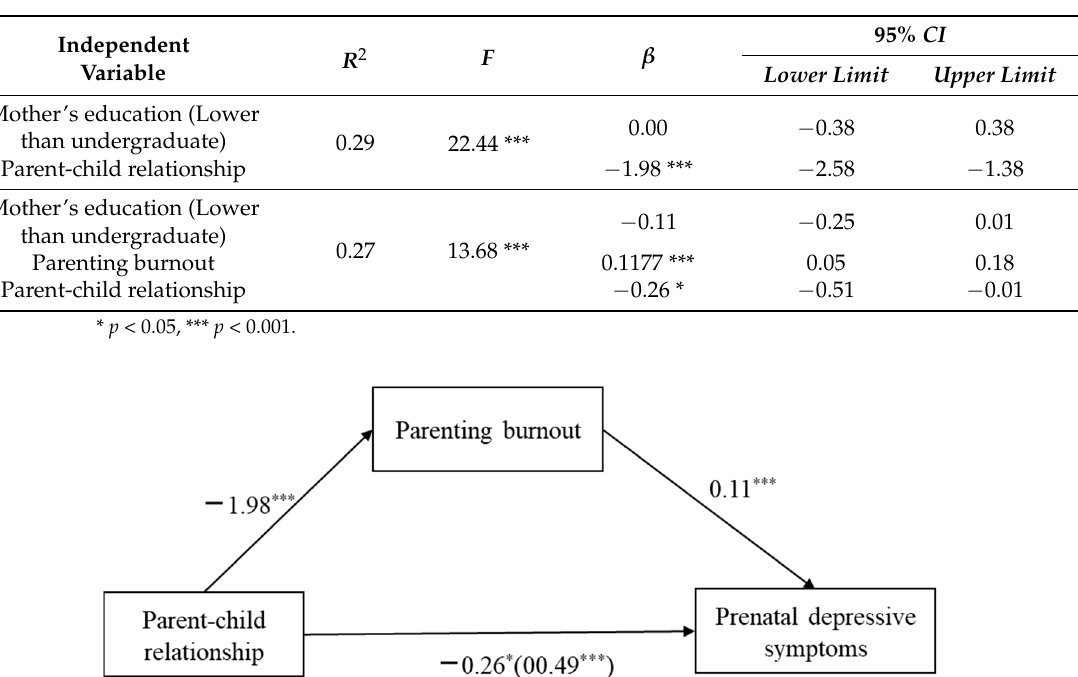
Table 4. The regression result with a mediator.